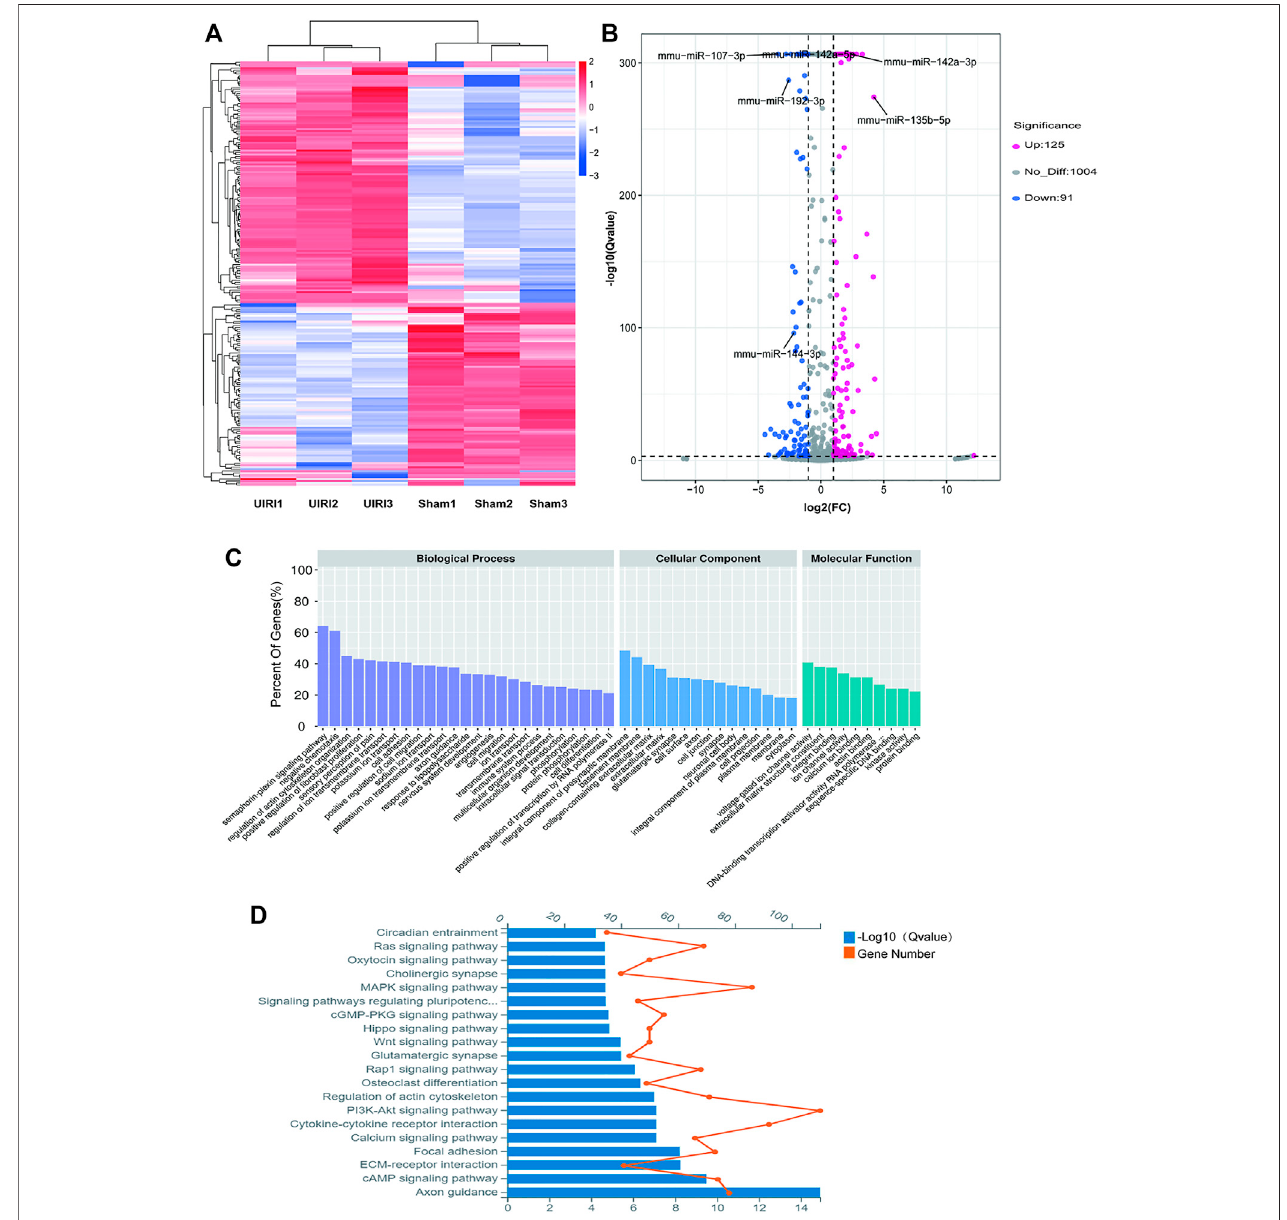
FIGURE 4 | Expression pro fi les and the enrichment analyses of the DE miRNAs. (A) The heatmap of the representative DE miRNAs. (B) Volcano plot showing signi fi cantlyDEmiRNAs.Red andblue pixelsrepresentupregulatedand downregulatedgenes, respectively; gray pixelsindicate geneswithno signi fi cantdifference.An absolutevalueoffold-change > 2.0and Qvalue < 0.001wereconsideredassigni fi cantlydifferent. (C) GOanalysisofthetargetsoftheDEmiRNAs. (D) KEGGanalysisof the targets of DE